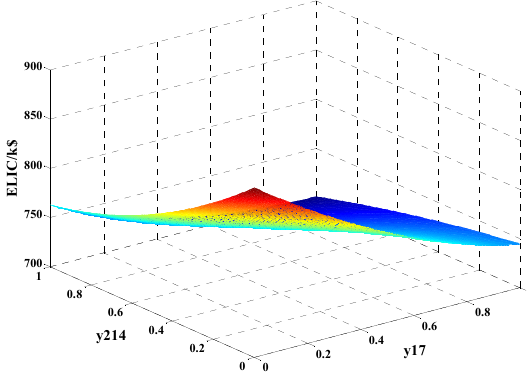
Figure 5. The value of ELIC impace with y 17 and y 214 .